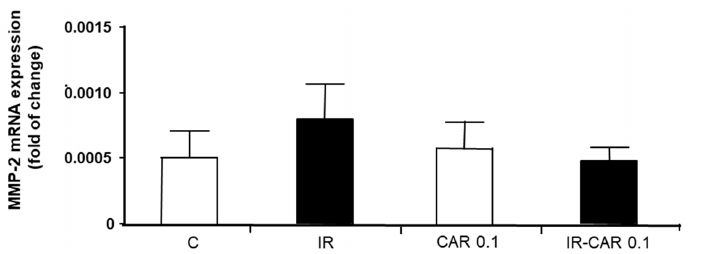
Figure 4. Effect of carvedilol on MMP-2 mRNA expression in hearts subjected to ischemia-reperfusion. Fold of change was calculated by delta-delta Ct formula. Glyceraldehyde 3-phosphate dehydrogenase served as a normalizing gene. C—control group, aerobically perfused hearts, IR injury—ischemia-reperfusion injury, CAR 0.1—aerobically perfused hearts treated with 0.1 μ M carvedilol, IR-CAR 0.1—hearts from IR injury model treated with 0.1 μ M carvedilol. p > 0.05, n = 5, ANOVA. 2.5. Carvedilol Does Not Affect MMP-2 Content in Coronary Effluent IR injury caused a significant increase in MMP-2 content, assessed by western blot, in coronary effluent in the second minute of reperfusion in both IR and IR-CAR 0.1 groups, but there were no significant differences between IR and IR-CAR 0.1 groups (Figure 5a,b). There were no significant differences in MMP-2 content in heart tissue between groups (data not shown).